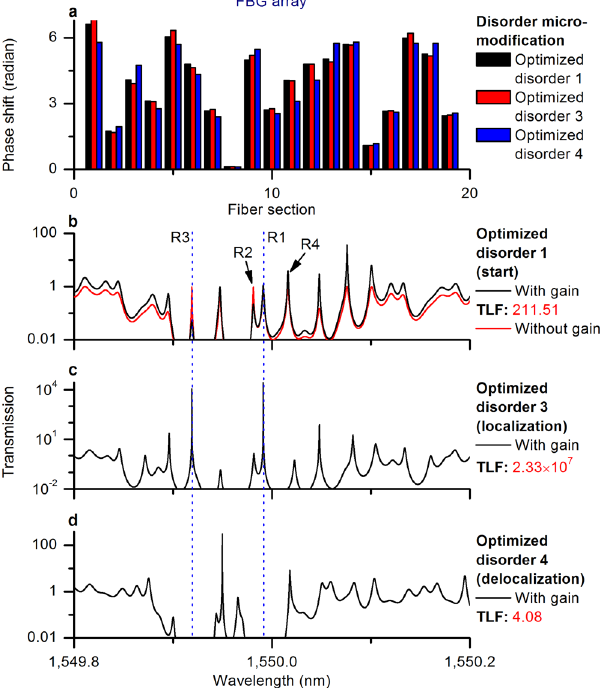
Figure 5. Two-way resonance optimizations between localization and delocalization of the amplified FBG array. ( a ) Optimized disorders. ( b ) Resonances of optimized disorder 1. ( c ) Resonances of optimized disorder 3. ( d ) Resonances of optimized disorder 4. TLF: total localization factor; gain rate: 20